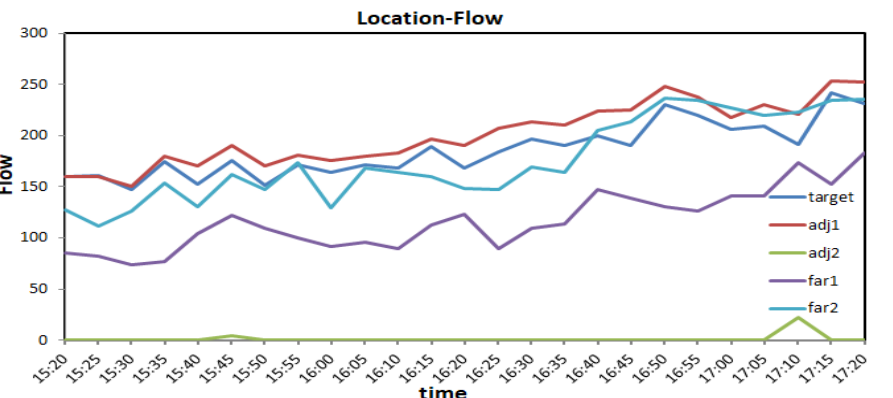
Figure 2. The target is the test node 1, adj1 is adjacent to node 2, adj2 is the reverse adjacent node 5, far1 is the remote node 3, and far2 is the remote node 4.